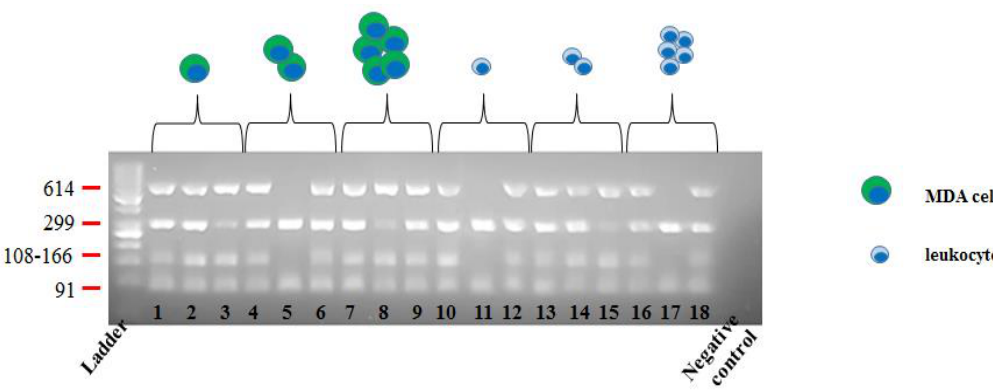
Figure 2. DNA integrity testing in sorted MDA / leukocytes cells. Multiplex PCR was performed and four PCR products of different lengths from four chromosomal regions were amplified. The number of bands obtained by each PCR product was visualized on a 3% agarose gel through ultraviolet light. Each lane represents a single / cellular pool.